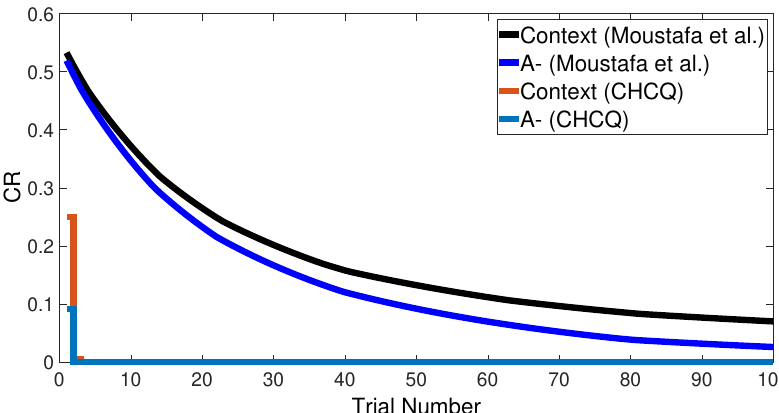
Figure 6. The cue contains context and stimulus A only as <A − >